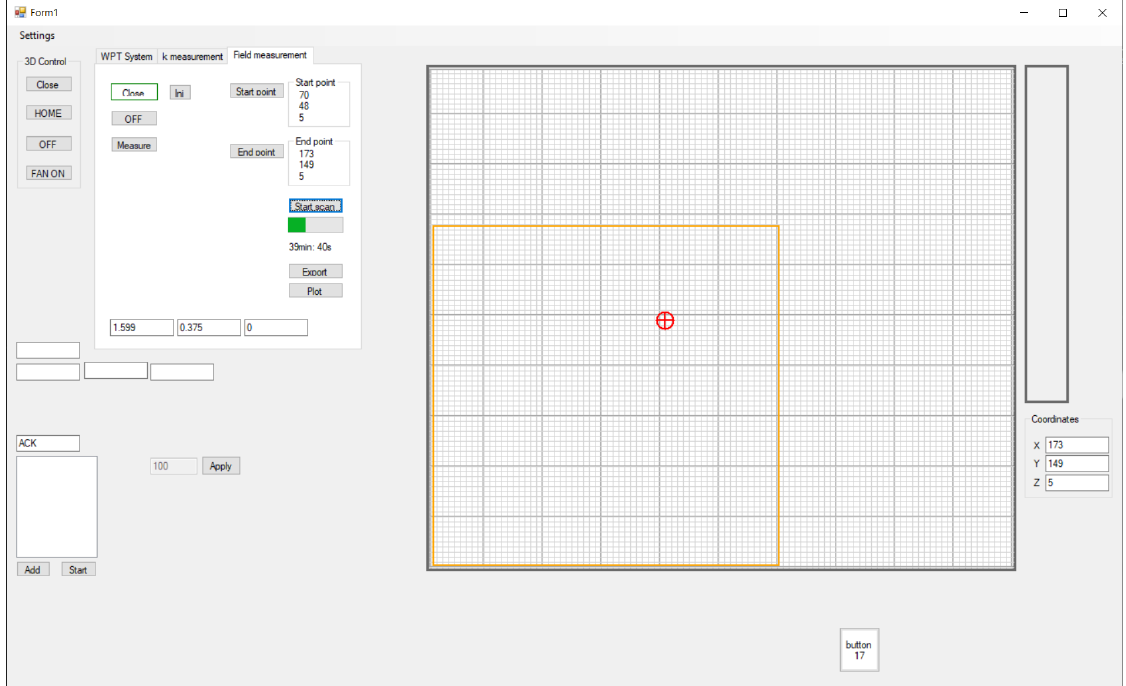
Figure 12. Control application for magnetic field measurement.